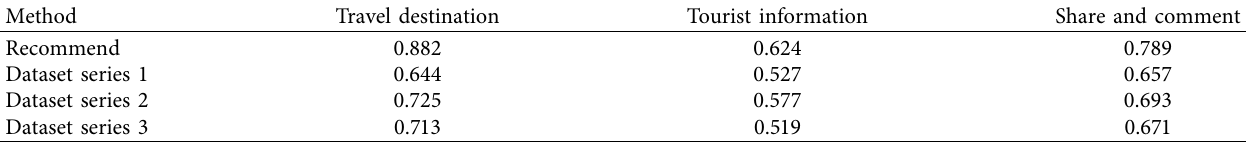
Table 2: Comparison of the classification accuracy of different algorithms for datasets.